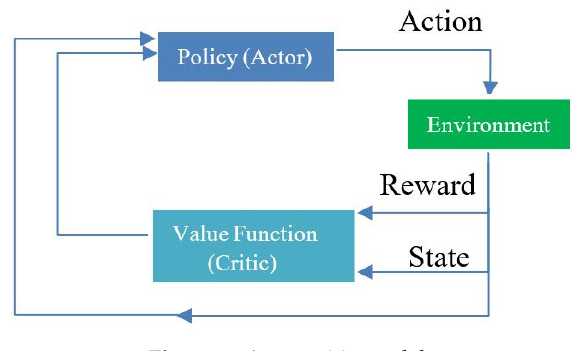
Figure 2. Actor-critic model.